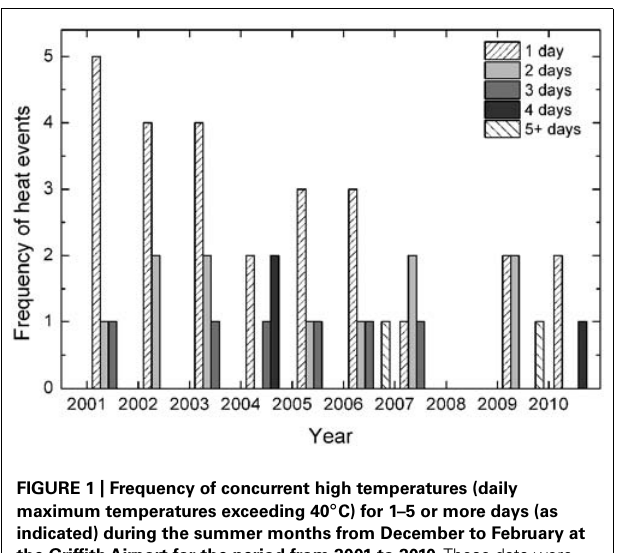
FIGURE 1 | Frequency of concurrent high temperatures (daily maximum temperatures exceeding 40 ◦ C) for 1–5 or more days (as indicated) during the summer months from December to February at the GriffithAirport for the period from 2001 to 2010. These data were provided by the Australian Bureau of Meteorology, 2011 for Station Number 075041.